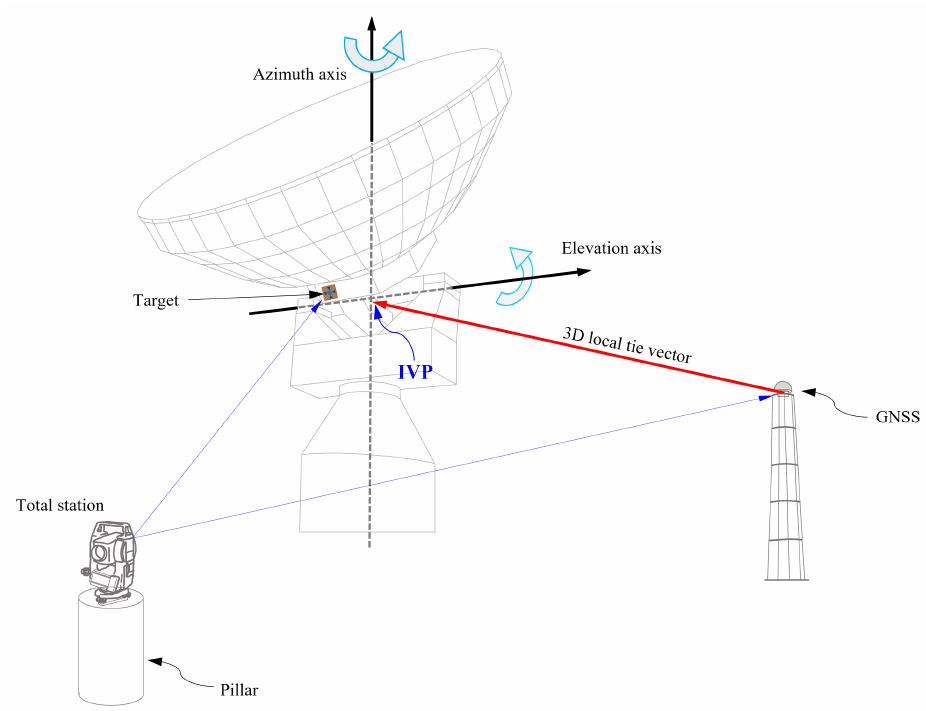
Figure 1. The schematic drawing of VLBI IVP estimation process. The IVP is the geometric center of the VLBI antenna, and the local tie vector with respect to the GNSS is the primary concern. The IVP is estimated based on the ground surveying measurements (slant distances, horizontal/vertical angles, etc.) from total station mounted on the permanent